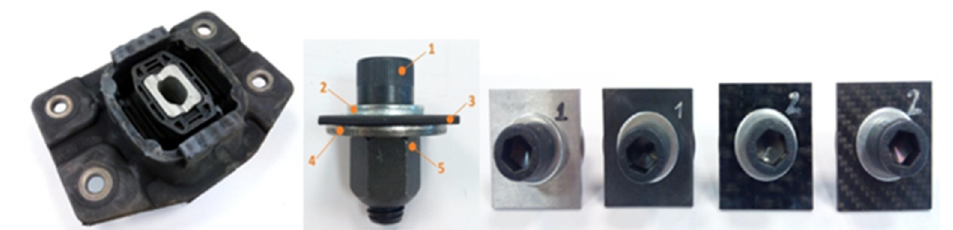
Figure 2. The torque test specimen assembly following a dry mounting configuration (bolt, nut, washers, metal part, and composite part).